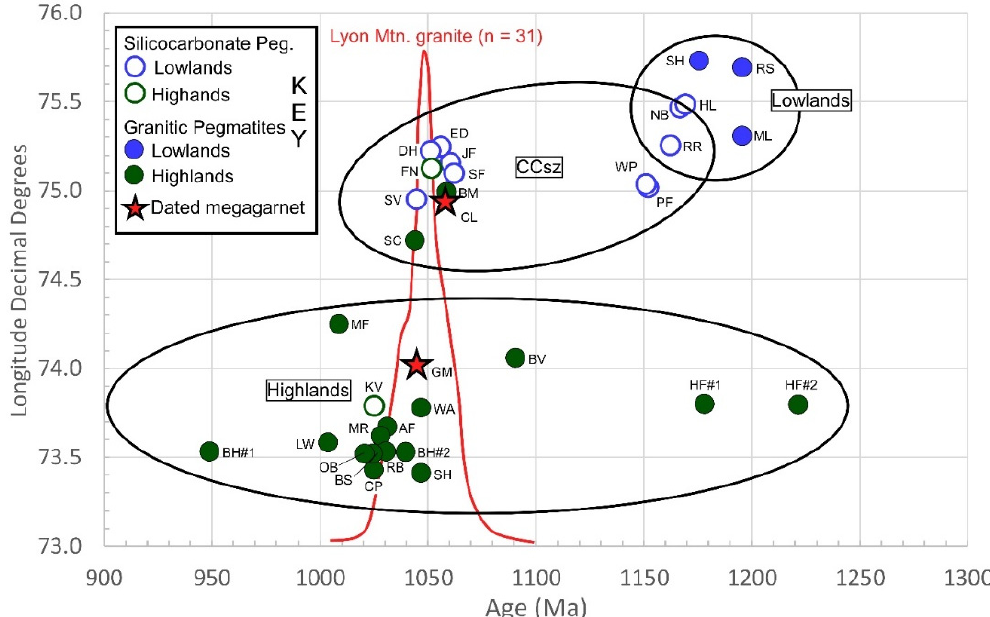
Figure 8. Plot of longitude versus age of pegmatites in the Adirondack Region. Green symbols are from the Highlands; blue from the Lowlands. Open circles are silicocarbonate pegmatites; closed circles are granitic pegmatites; red stars are dated megagarnet localities. The red histogram is from Reference [35] and shows the range of ages for the Lyon Mountain granite in the Highlands. Abbreviations: